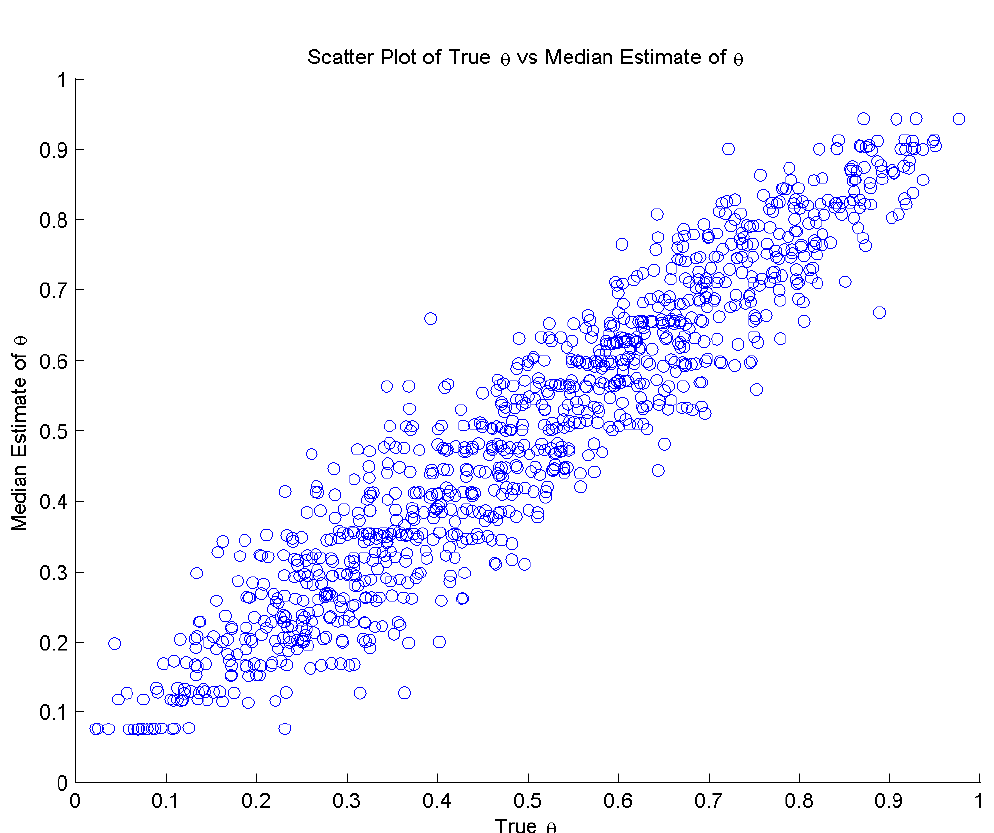
Figure 4. Scatter Plot of True and 2P CTM Median Estimate of θ . This figure illustrates the relationship between true and 2P CTM median estimates from the simulation dataset ( n = 1000). Table 3. Statistics for the Parameter Replicability Analysis.